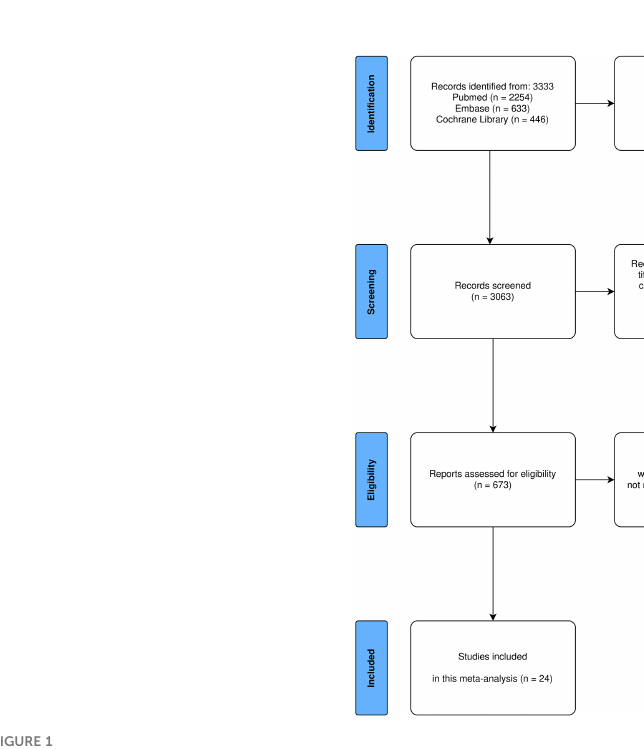
FIGURE 1 Flowchart of study selection.